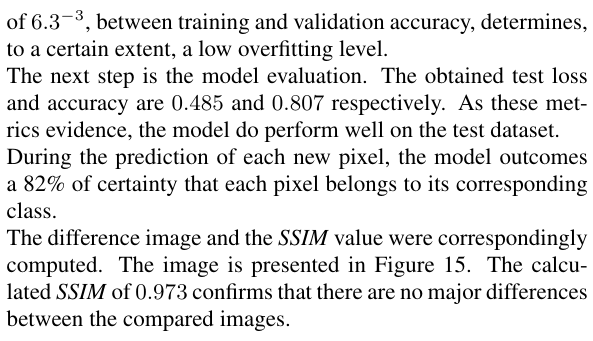
Figure 14. Greding difference image.